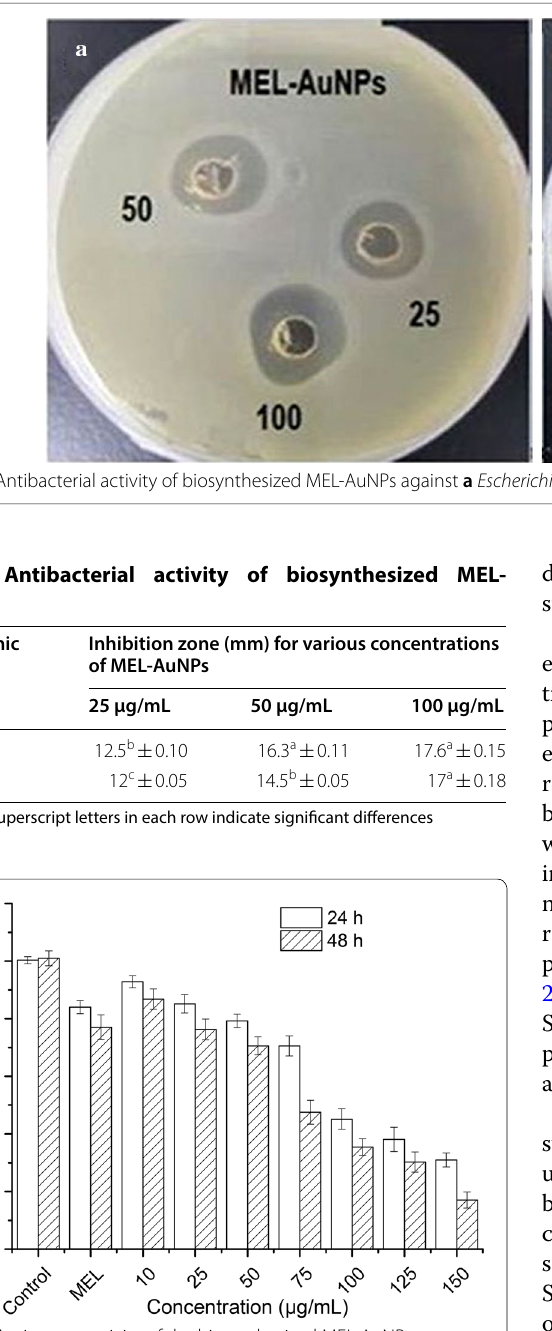
Fig. 6 Anticancer activity of the biosynthesized MEL-AuNPs against HepG2 cells after 24 h and 48 h. Each result represented the mean standard deviation (SD) and performed in ±